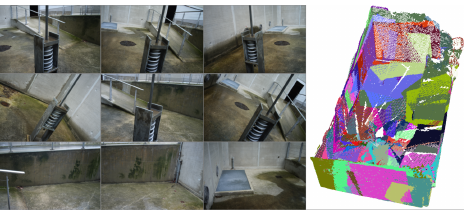
Figure 15. Partrition of scene between master images in Case 1. Left: some images, right: each color represents a selected part of the scene on one master